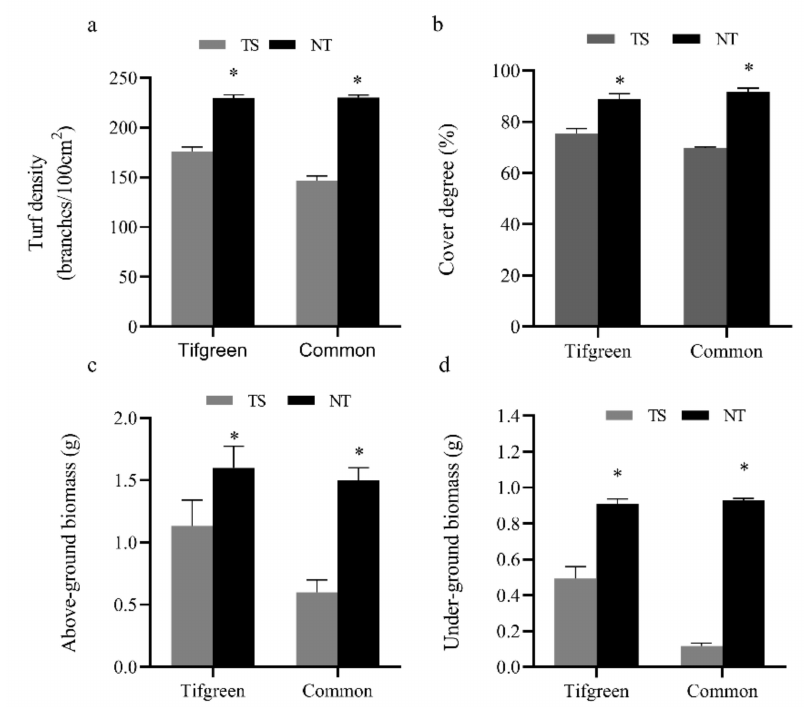
Figure 3. Turf quality indicators under traffic stress. ( a ) turf density, ( b ) cover degree, ( c ) above- ground biomass, ( d ) under-ground biomass. Note: * p < 0.05 under diverse treatments. TS: traffic stress; NT: non-traffic